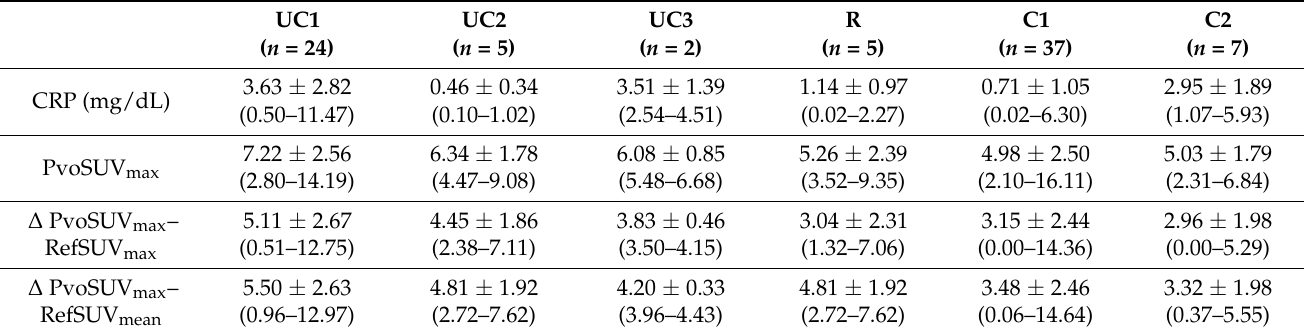
Table 4. Differences of CRP and FDG uptake between